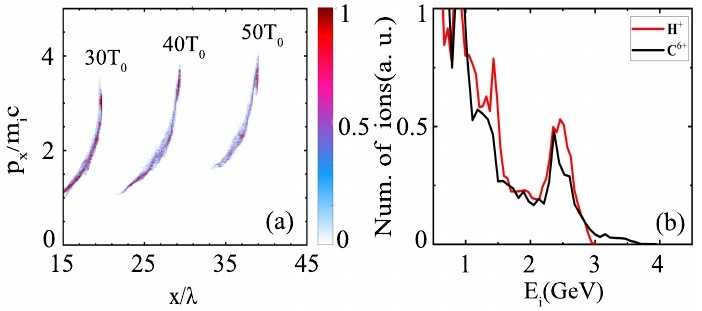
Figure 7. ( a ) Phase space p x − x of protons at t = 30 T 0 , t = 40 T 0 , and t = 50 T 0 , respectively. ( b ) Spectra of protons (red line) and carbon ions (black line) at t = 50 T 0 . Here, the laser and target parameters are the same as those in Figure